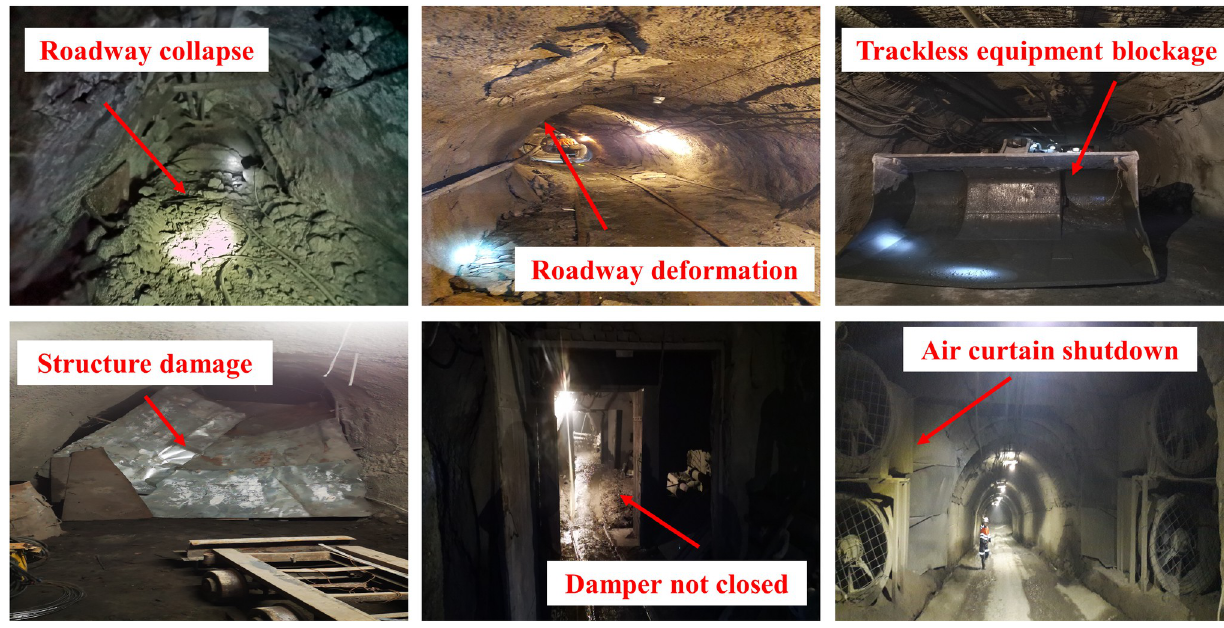
Fig 1. Resistance variant faults in a real mine. (Created by the